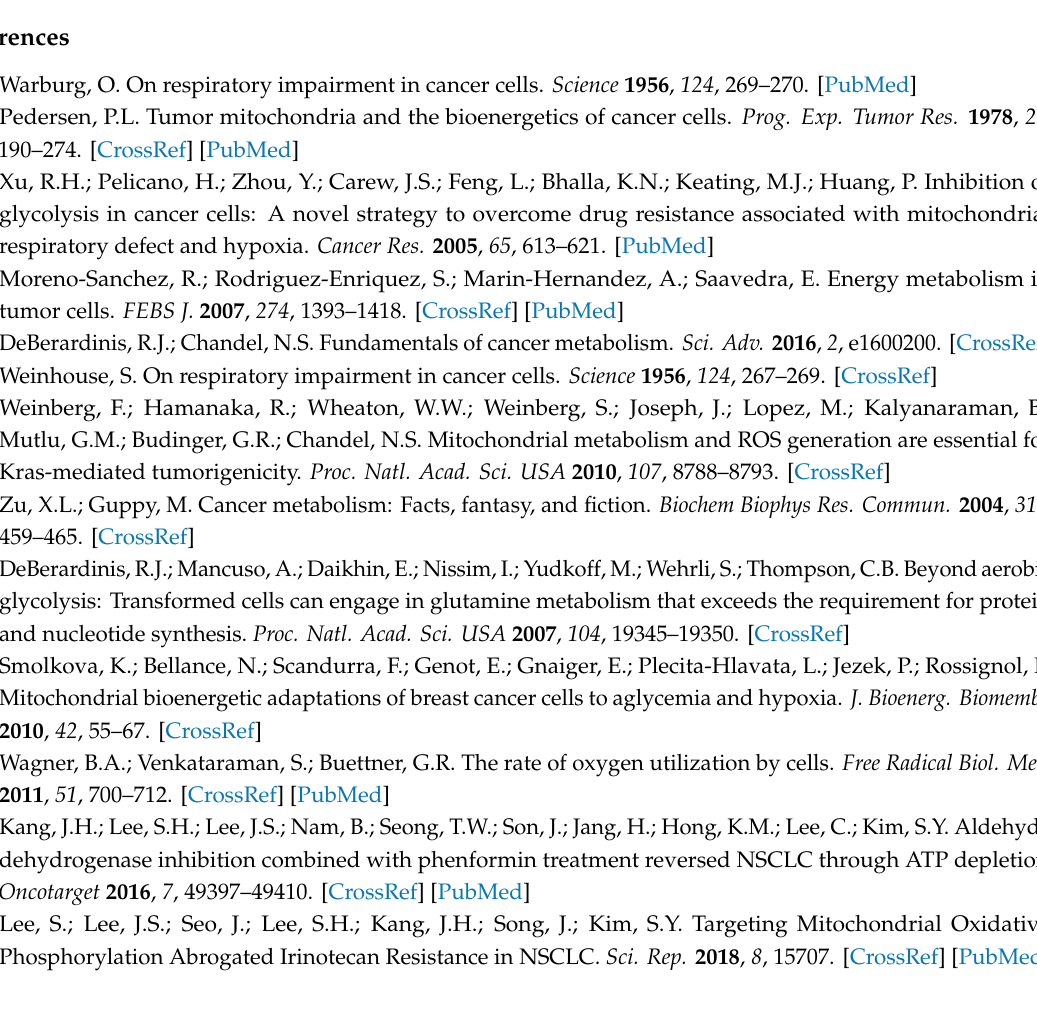
Figure S1: Glucose deprivation was not able to a ff ect basal consumption rate and ATP production. Figure S2: E ff ect of supplementary fatty acids on basal respiration and ATP production in PDAC and normal cells. Figure S3: E ff ect of inhibition of MAS and FAO on cell proliferation and cell death. Table S1: Formula of High-Fat Diet and Low-Fat Diet. Table S2: Alterations of genes in pancreatic cancer cell